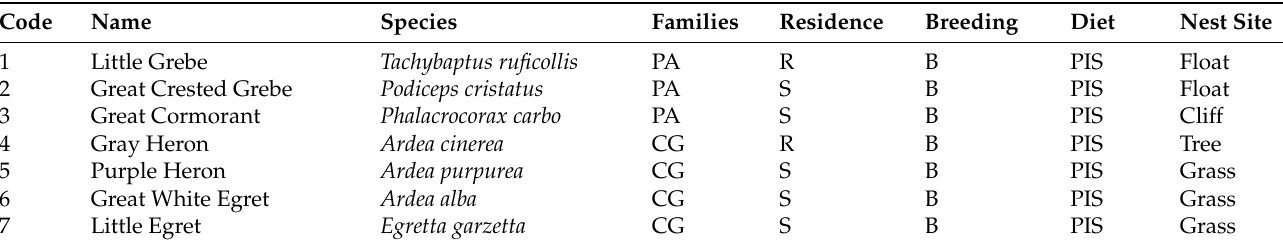
Table A1. List of waterbird species and their categorical